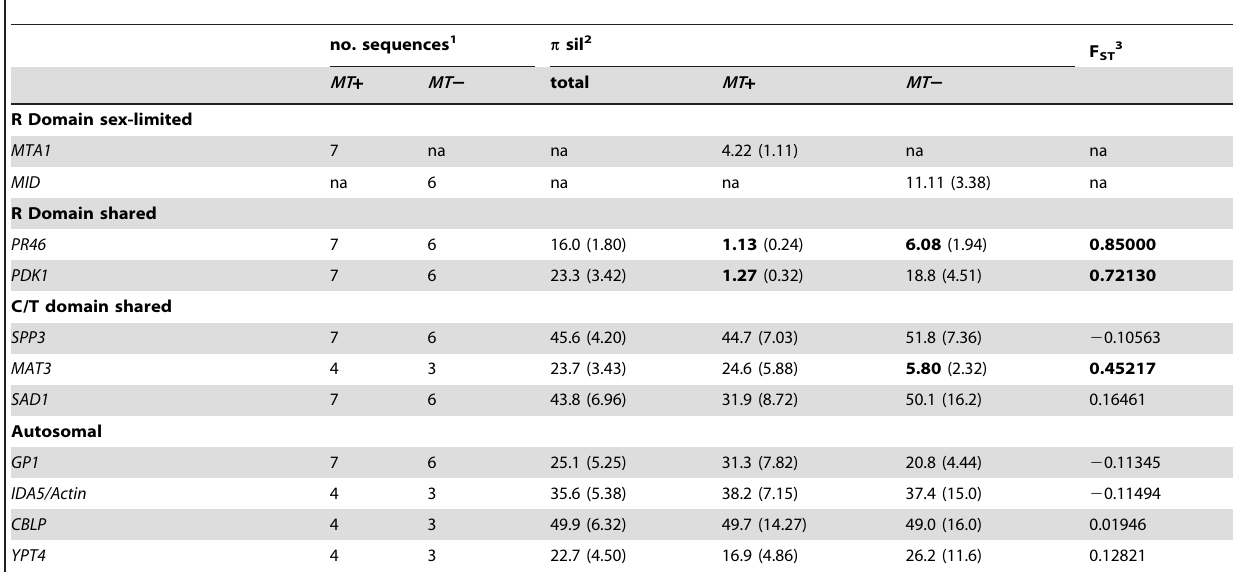
Table 1. Population genetic data for MT and autosomal genes.